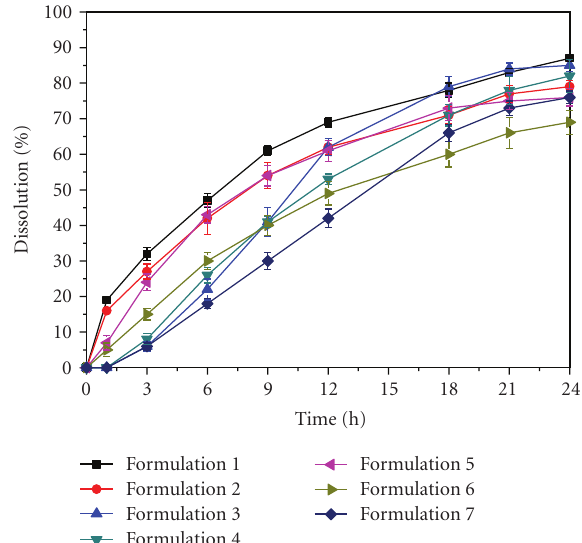
Figure 1: In vitro dissolution profile of the best formulation prototypes (Boehringer